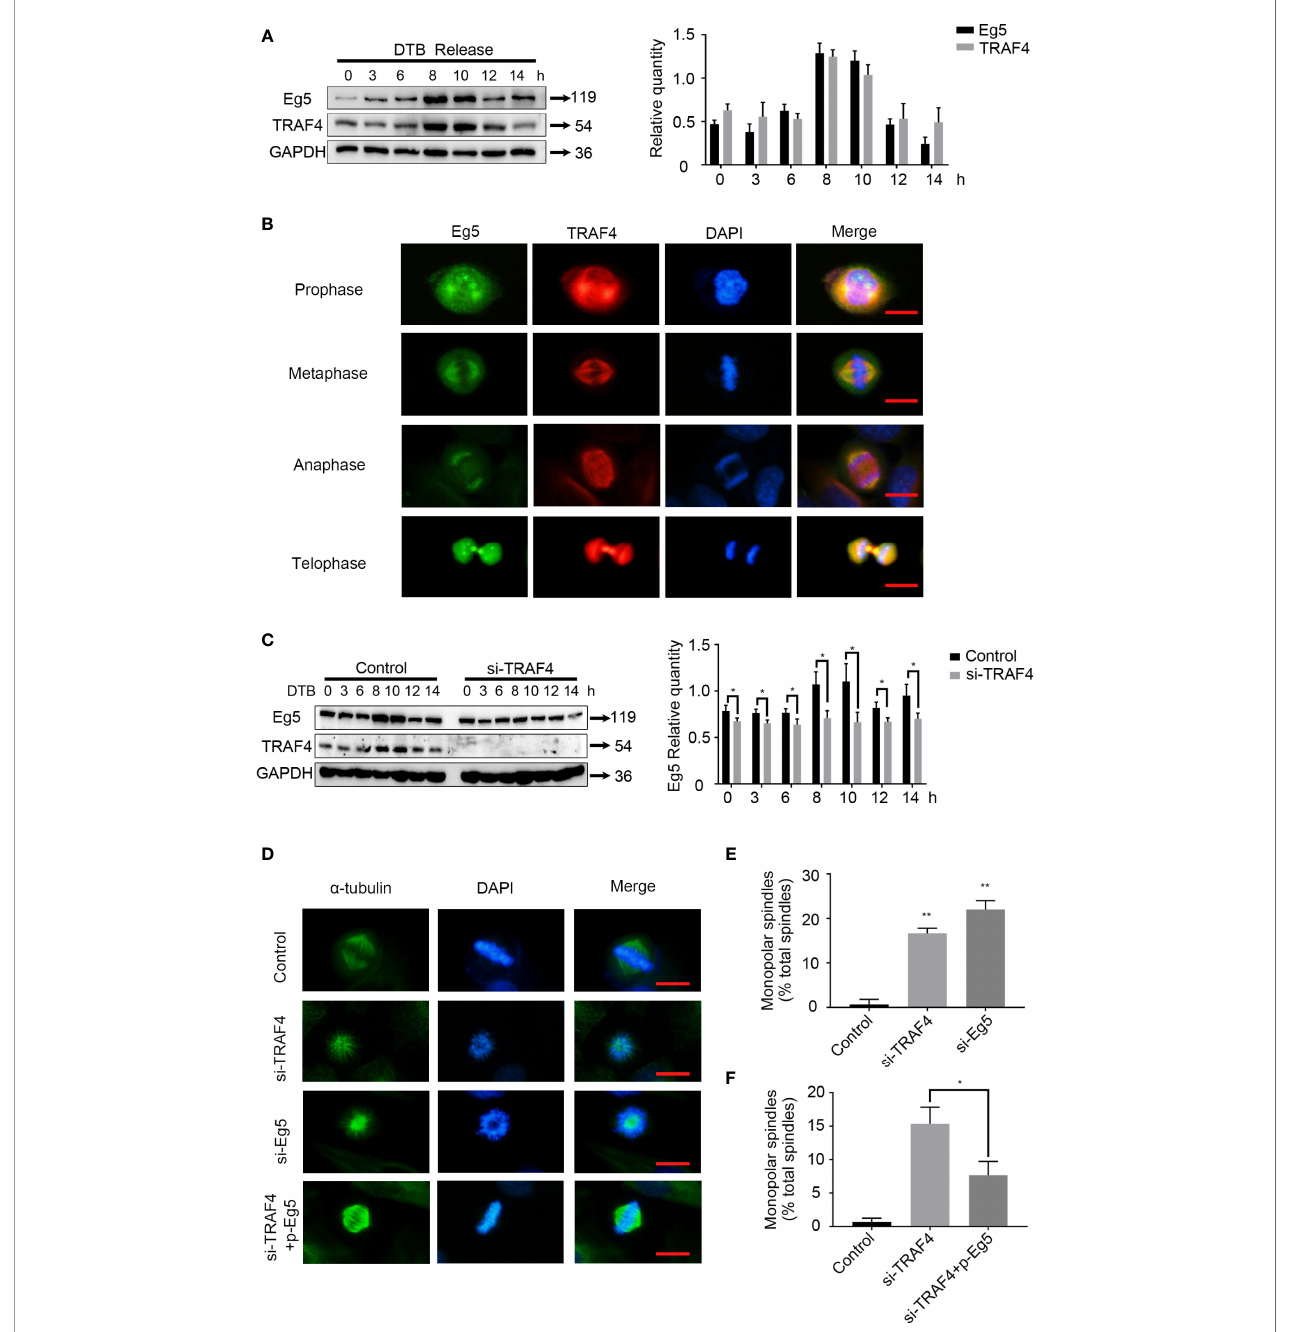
FIGURE 3 | TRAF4 is involved in spindle assembly through regulating the protein level of Eg5. (A) MCF-7 cells were synchronized by double thymidine block, and were collected at 0, 3, 6, 8, 10, 12 and 14 hours after release. Western blot assays were used to demonstrate the protein level of TRAF4 and Eg5. GAPDH was used as an internal control. (B) Co-localization of endogenous TRAF4 and Eg5 during different phases of mitosis in MCF-7 cells. TRAF4 and Eg5 were detected by immuno fl uorescence assay using antibodies against TRAF4 (red) and Eg5 (green). Bar, 20 m m. (C) MCF-7 cells were synchronized by double thymidine block and transfected with or without TRAF4 si- RNA. Collected the cells at the time mentioned above and protein level were analyzed by western blot. Data represent mean ± SD ( n = 3). (* p < 0.05). (D) Depletion of TRAF4 and Eg5 led to monopolar spindle formation. Synchronized MCF-7 cells were transfected with the indicated si-RNAs. Immuno fl uorescence assays were used to evaluate spindle morphology using antibodies against a -tubulin. Chromosomes were stained by DAPI. Bar, 20 m m. (E) Summary of the frequency of monopolar spindles in MCF-7 cells transfected with control si-RNA, TRAF4 si-RNA or Eg5 si-RNA. **p < 0.001. (F) Summary of the frequency of monopolar spindle in MCF-7 cells transfected with control si- RNA or TRAF4 si-RNA with or without Eg5 protein level vector. Data represent mean ± SD ( n = 3). (* p <